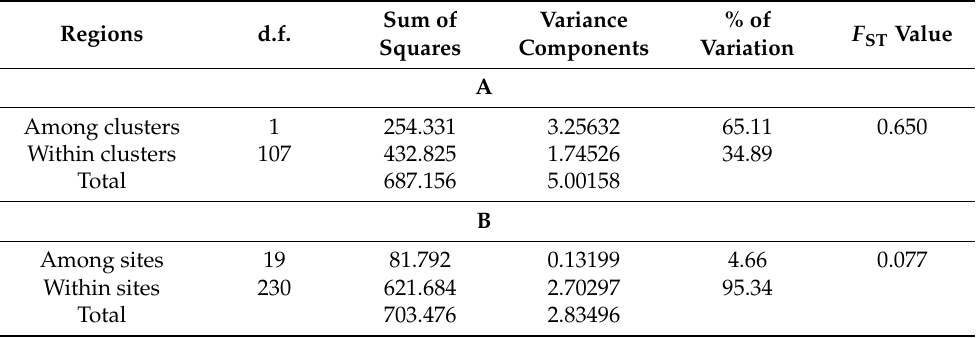
Table 6. ( A ). AMOVA analysis performed on 109 unique genotypes of P. halstedii . Comparisons are by cluster. ( B ). Analysis of molecular variance (AMOVA). AMOVA analysis of 250 P. halstedii isolates in the study. Comparisons are by